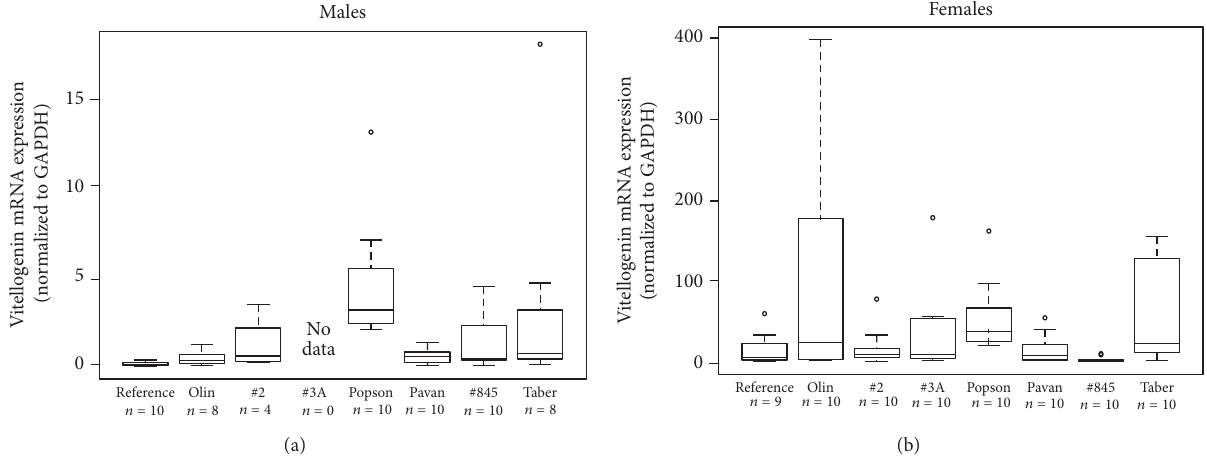
F 5: Box plots illustrating normalized liver vitellogenin mRNA expression in male (a) and female (b) longnose dace ( Rhinichthys cataractae ) from the Oldman River, Alberta sampled during August and September 2009. Vitellogenin mRNA expression is normalized to GAPDH. ere were insufficient males collected from Highway 3A to analyze male vitellogenin mRNA. e box plot labeled “reference” is for dace collected at Popson Park and reared in the laboratory for 7 months in clean water and commercial